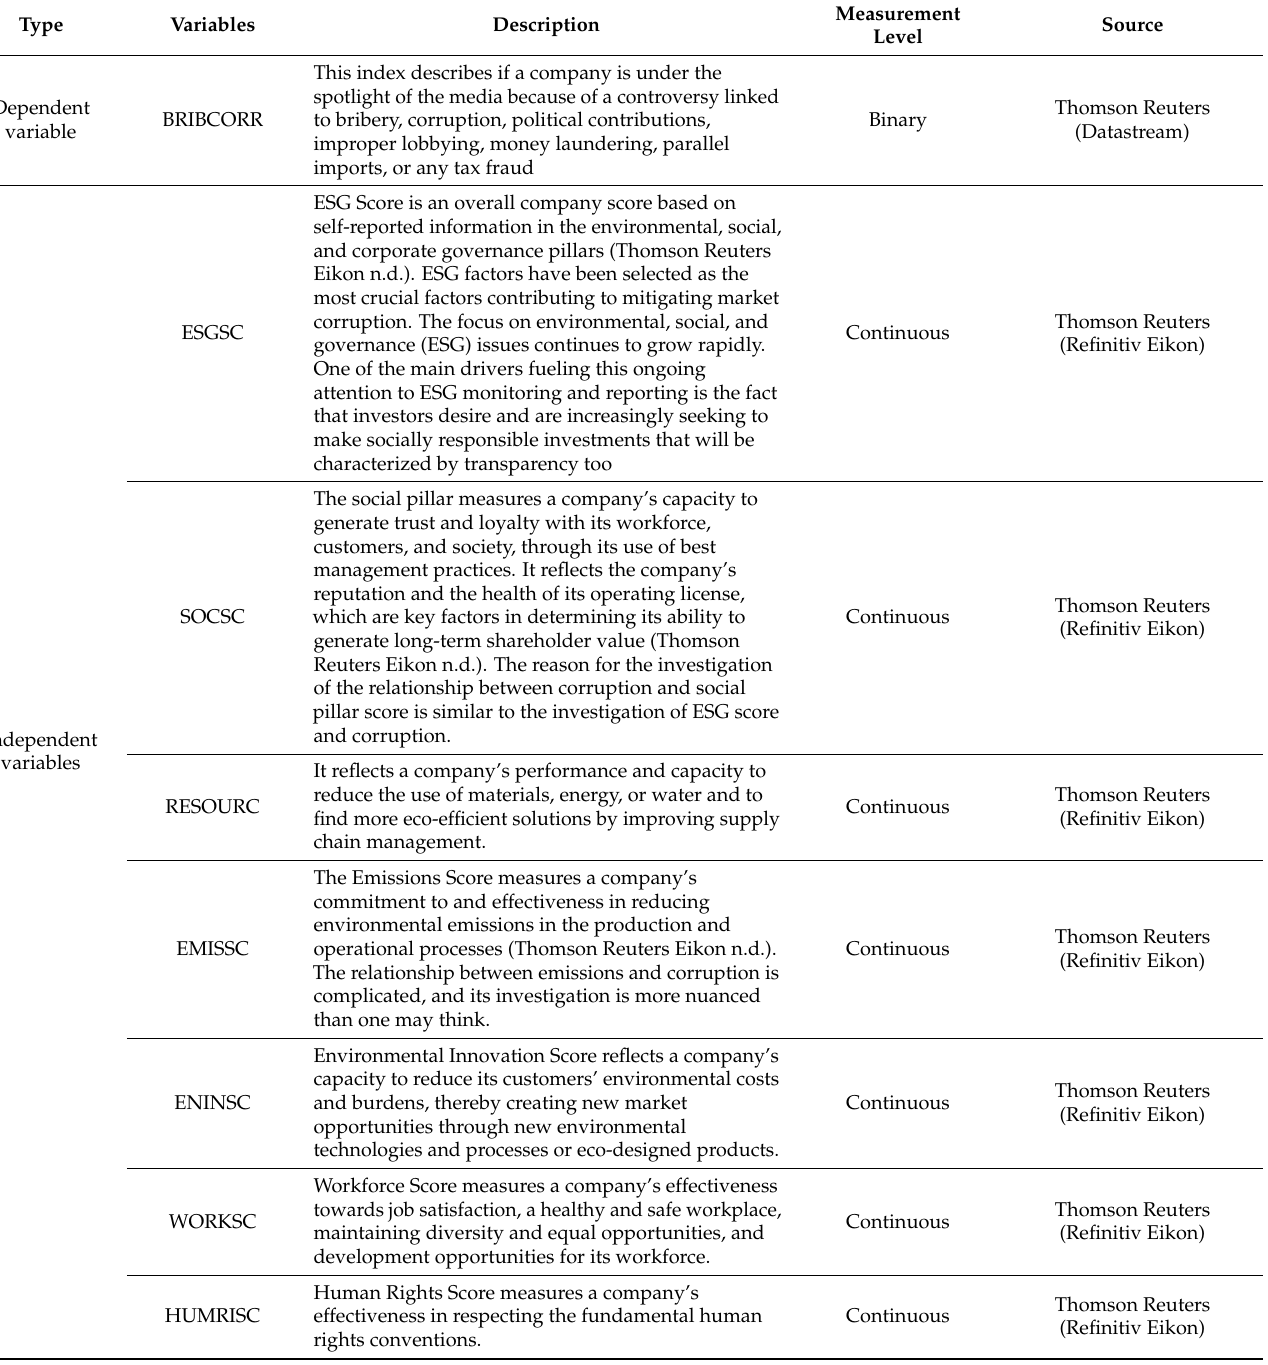
Table 3. Variables of the